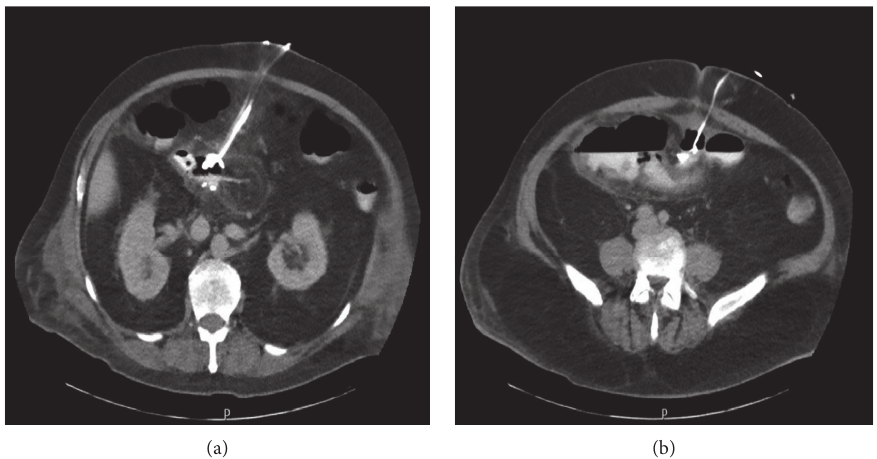
Figure 7: CT showing drainage catheters at the anastomotic